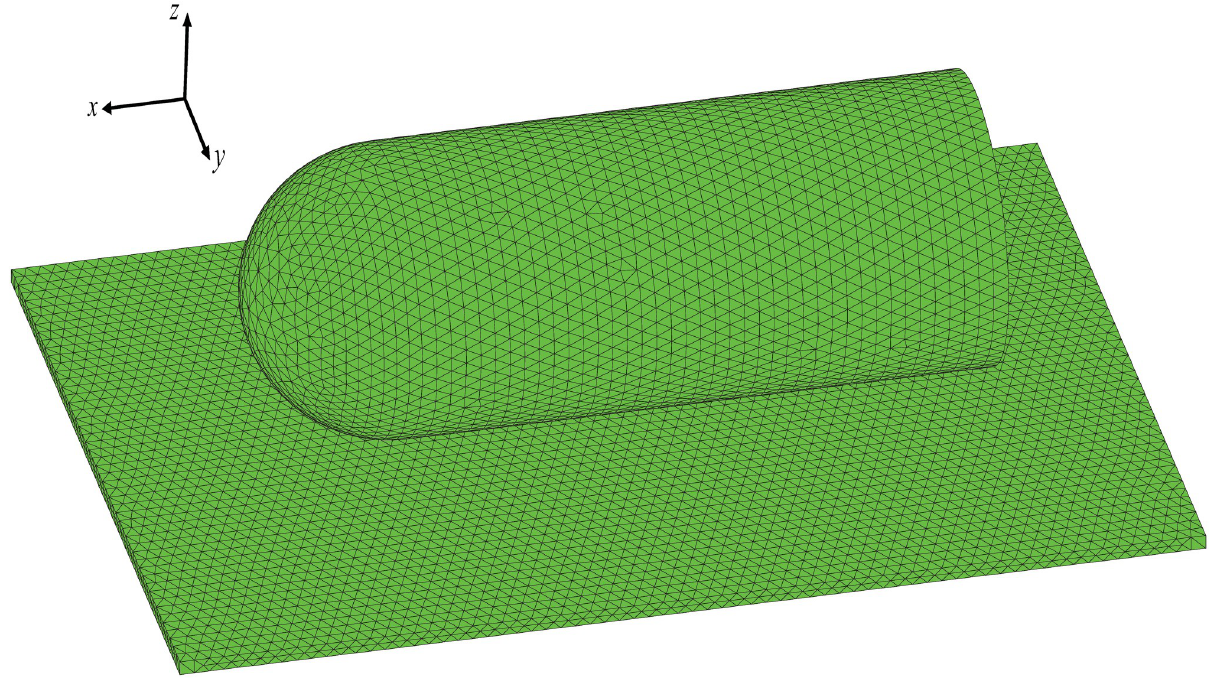
Fig 5. Test case of multi-object model.